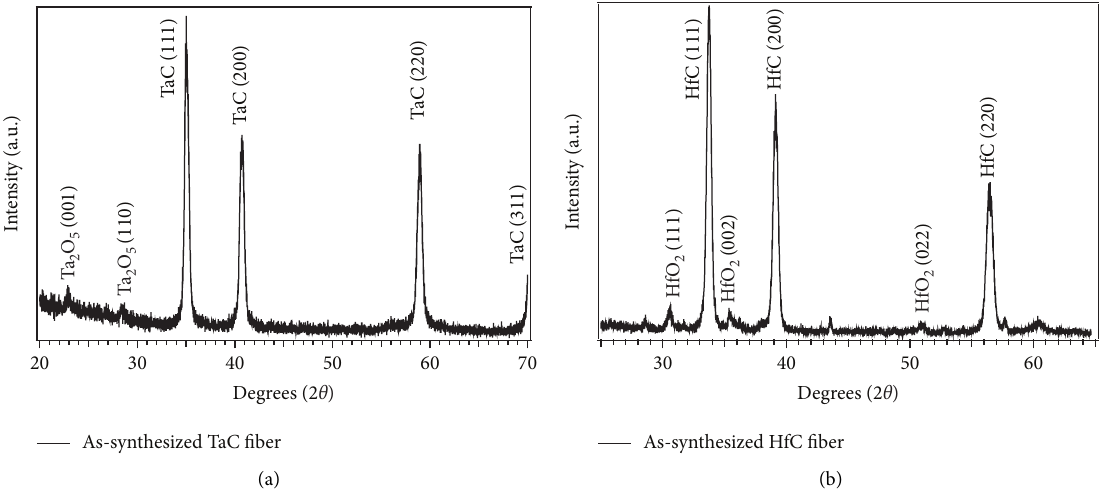
Figure 3: (a) PXRD spectra of as-synthesized TaC indexed with TaC (PDF# 00-035-0801). (b) PXRD spectra of as-synthesized HfC indexed with HfC (PDF#